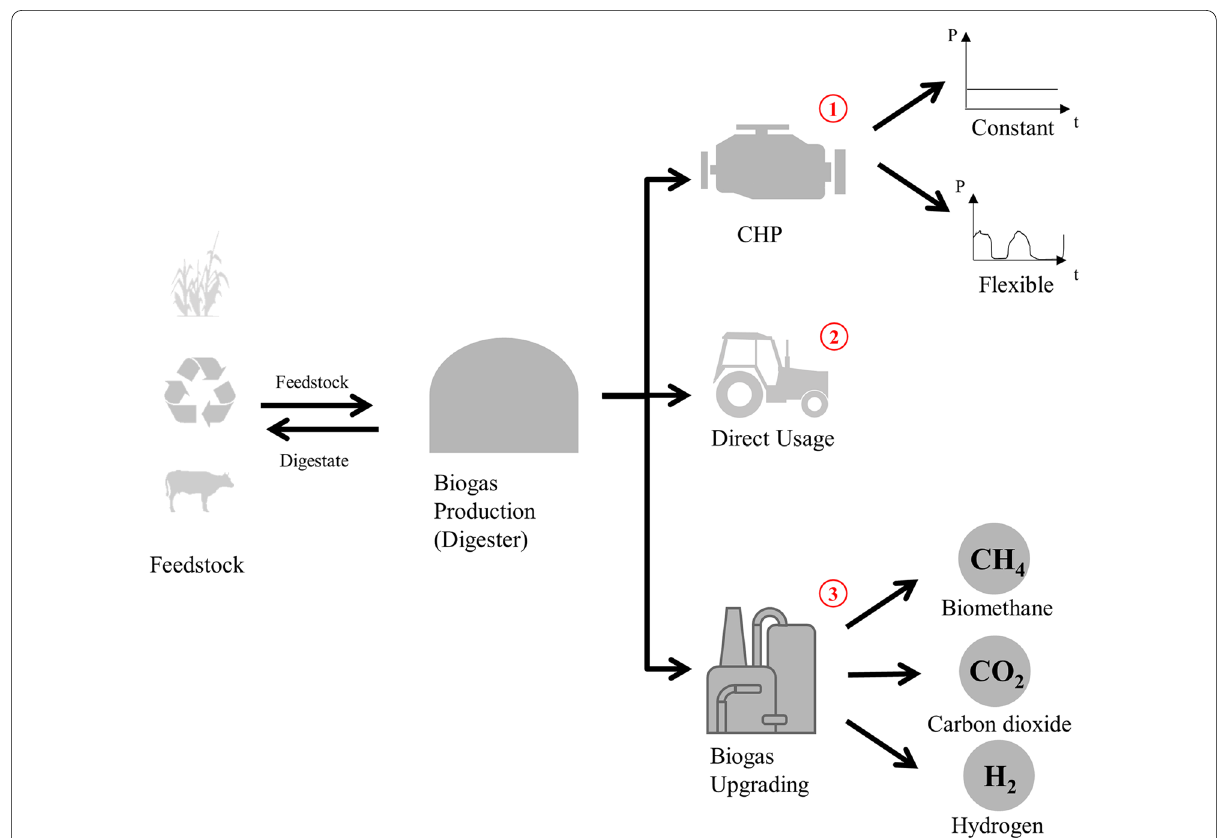
Fig. 1 Potential utilization pathways for